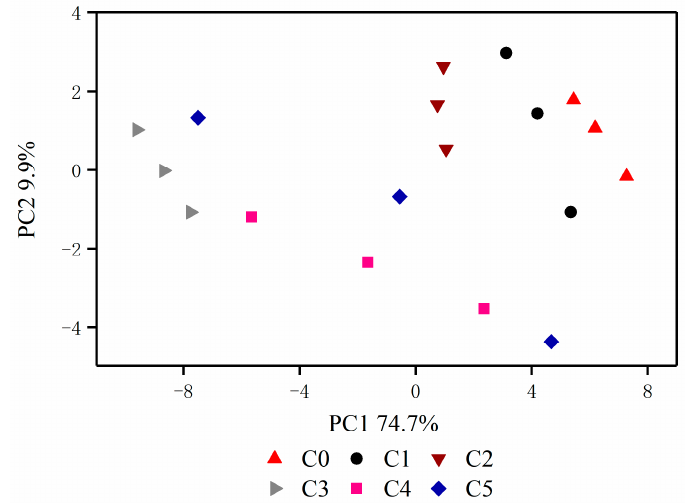
Figure 1. Principal coordinate analysis (PCA) plot of soil bacterial community structure in glucose treatments using the relative abundance of order. Principal components 1 and 2 explained 74.7% and 9.9% of the variance, respectively.